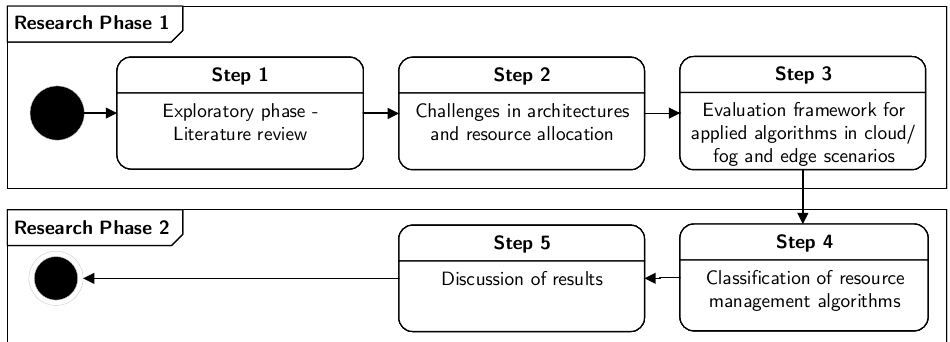
Figure 1. Research methodology followed throughout this